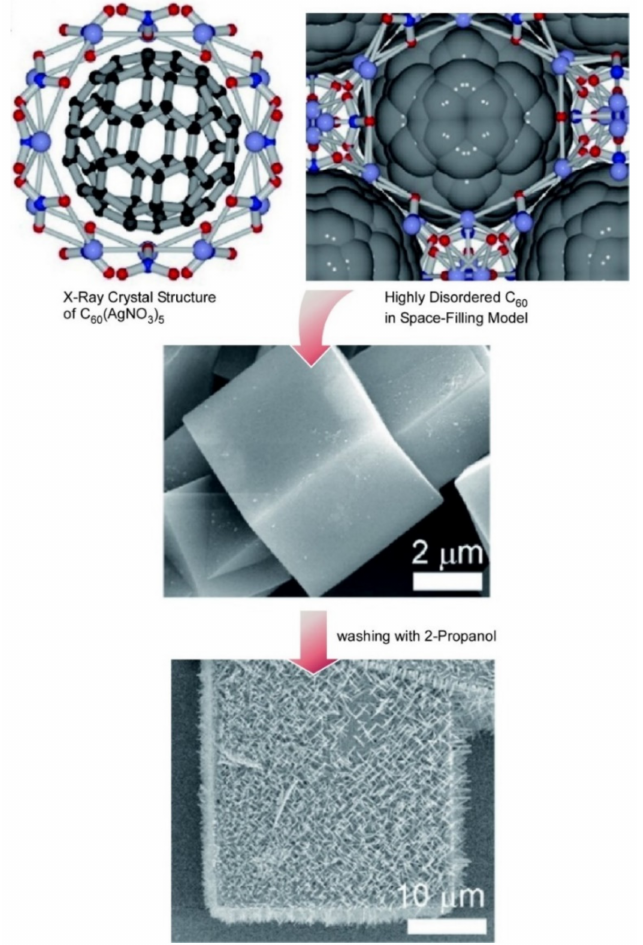
Figure 13. A cubic-type supramolecular fullerene C 60 -AgNO 3 nanomaterial in which treatment with 2-propanol causes the growth of fine, needle-like C 60 crystals on the cubic surface. Reprinted with permission from [167]. Copyright 2021, Chemical Society of